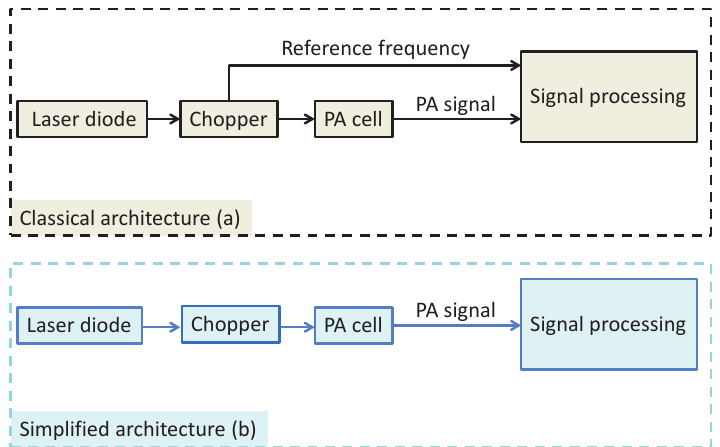
Figure 6. Architectures of LIA involved in a PAS-based NO 2 sensor.